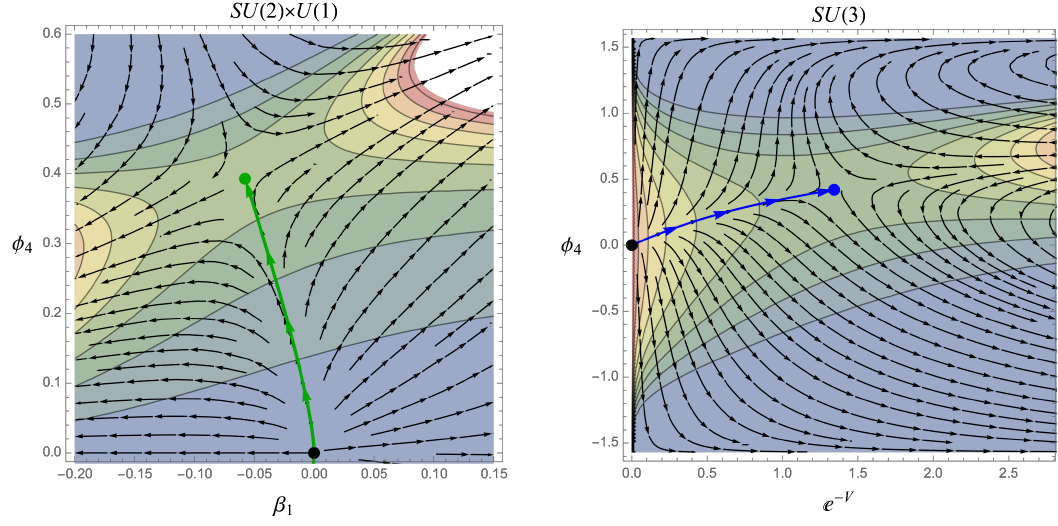
Figure 2 . RG flows from AdS 5 to AdS 4 × R S-folds. The stream plots are in the direction of decreasing r and the contours are constant lines of P . The left plot is for the SU(2) × U(1) invariant truncation: the green dot is the SU(2) × U(1) invariant N = 2 S-fold, the black dot is the AdS 5 vacuum and one sees a unique RG flow connecting them. The right plot is for the SU(3) invariant truncation: the blue dot is the N = 1 S-fold and one sees a unique RG flow connecting it with the AdS 5 vacuum solution, again marked with a black dot, which is located at V → ∞